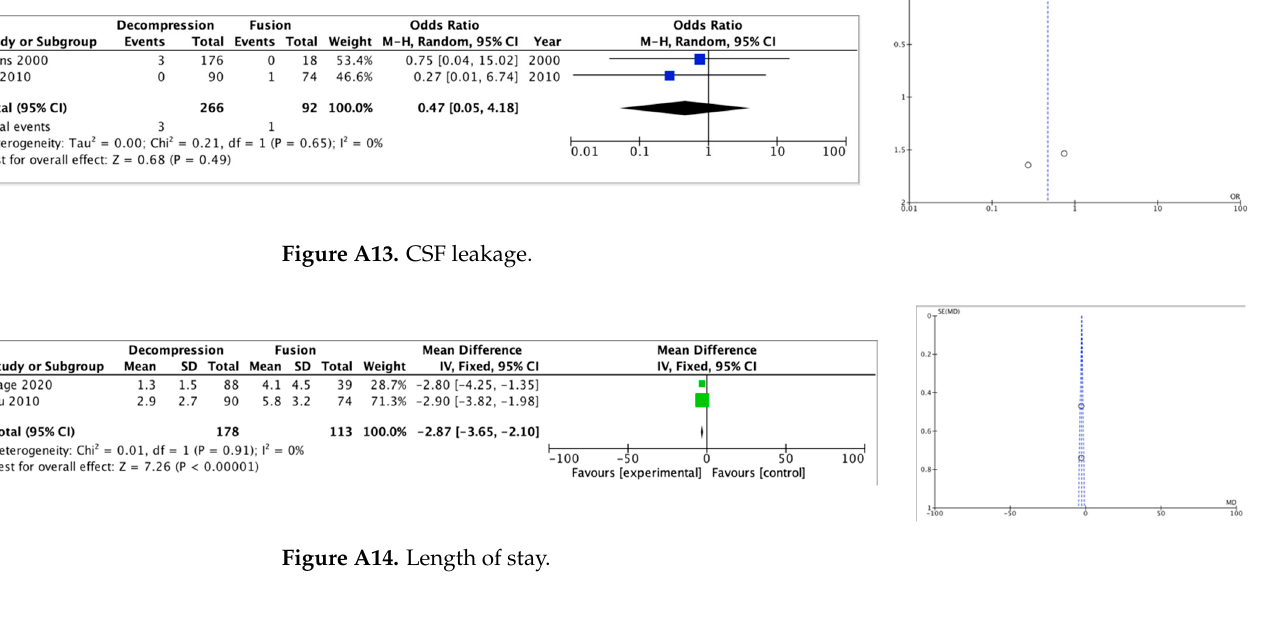
11 of 13 Figure A9. Re-operation. Figure A10. Post-op back pain. Figure A11. Post-op radiculopathy.